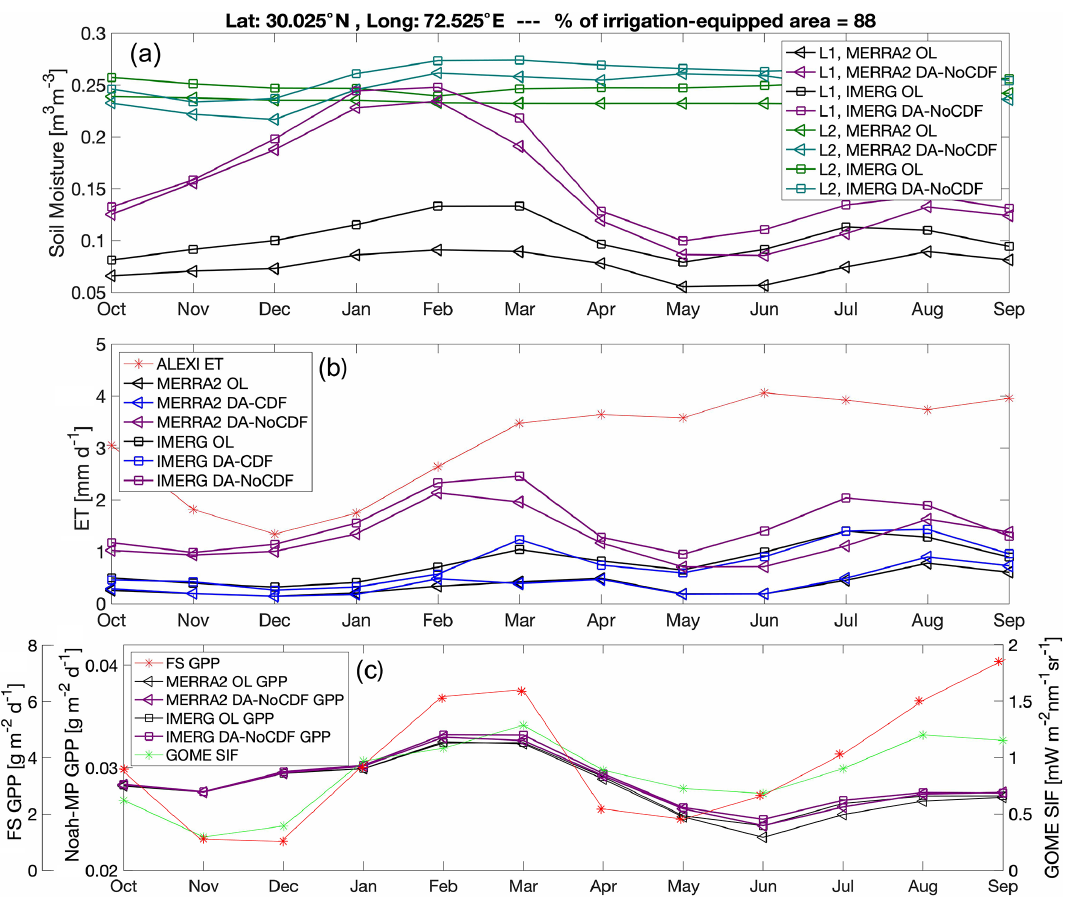
Figure 9. Influence of SMAP soil moisture (SM) assimilation on an irrigated location is assessed through soil moisture of successive soil layers (L1 and L2), evapotranspiration (ET), and the corresponding behavior of the dynamic vegetation. ALEXI ET (Sect. 3.2.3), FluxSat gross primary production (FS GPP; Sect. 3.2.4), and GOME solar-induced chlorophyll fluorescence (SIF; Sect. 3.2.5) are used as evaluation datasets. (a) L1 is layer 1 near-surface SM, and L2 is layer 2 root-zone SM. Noah-MP-modeled ET exhibits similar temporal patterns to the near-surface SM (L1); however, root-zone (L2) SM and GPP are not correspondingly modulated. DA-CDF is assimilation with CDF matching, and DA-NoCDF is assimilation without CDF matching.